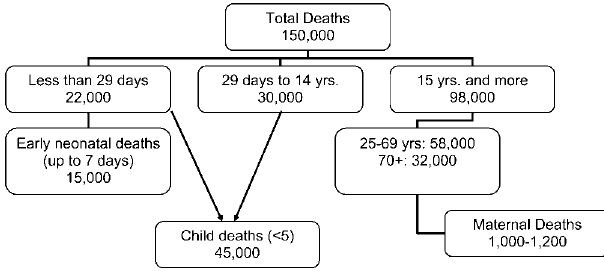
Figure 2. Expected Number of Deaths by Age Group Using VA (Thousands), 2001 to 2003 DOI: